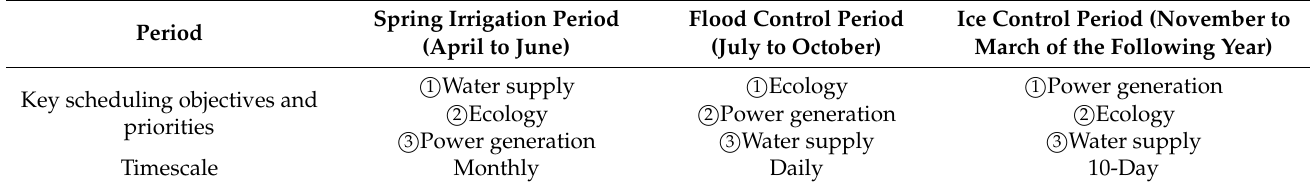
Table 2. Scheduling period divided by scheduling